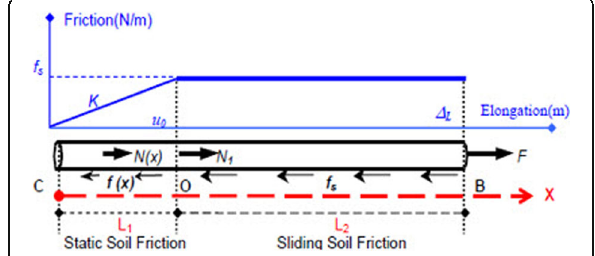
Fig. 3 Boundary conditions simulating infinite length of pipe (Liu et al., 2004a; Liu et al,